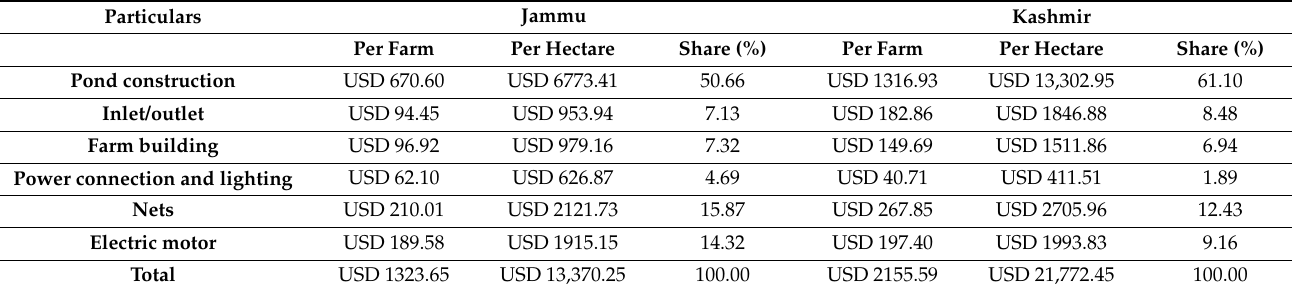
Table 2. Fixed capital investment pattern on sample carp farms (USD).